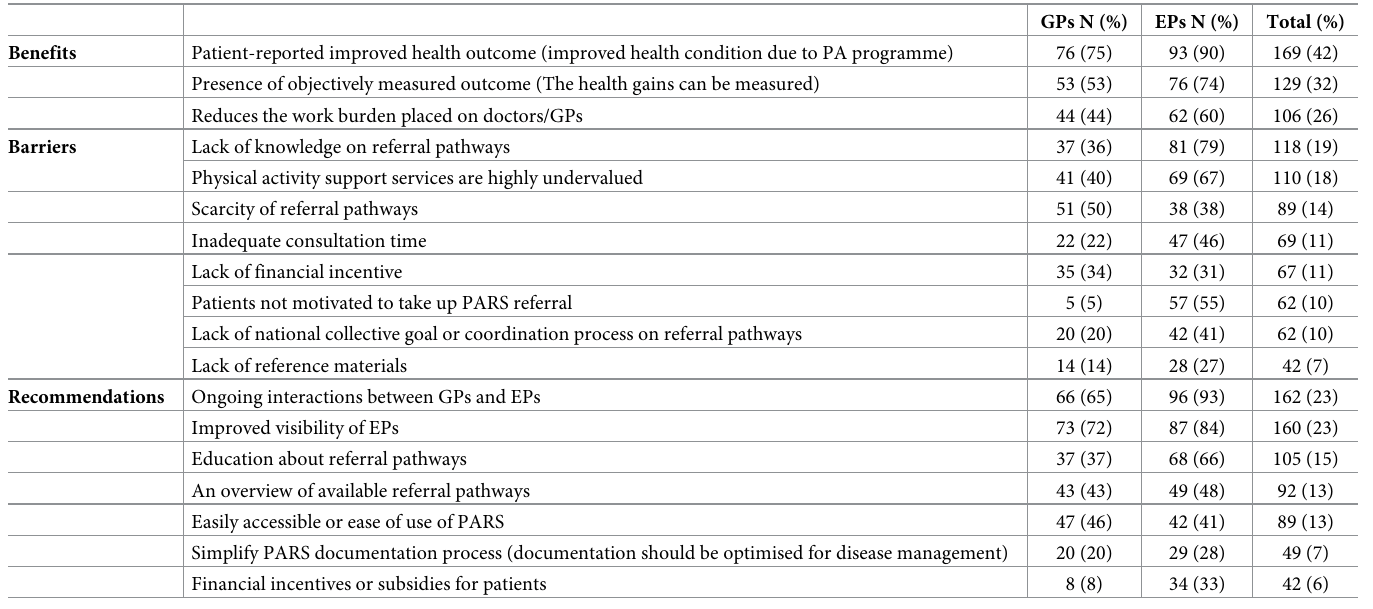
Table 5. Perceived benefits, barriers, and recommendations about PARS (N =